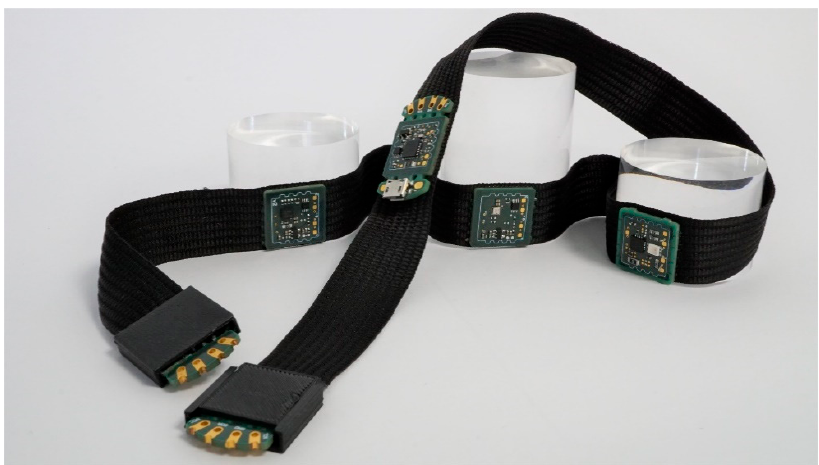
Figure 6. Different TPL modules bonded to a ribbon belt with the E-Textile